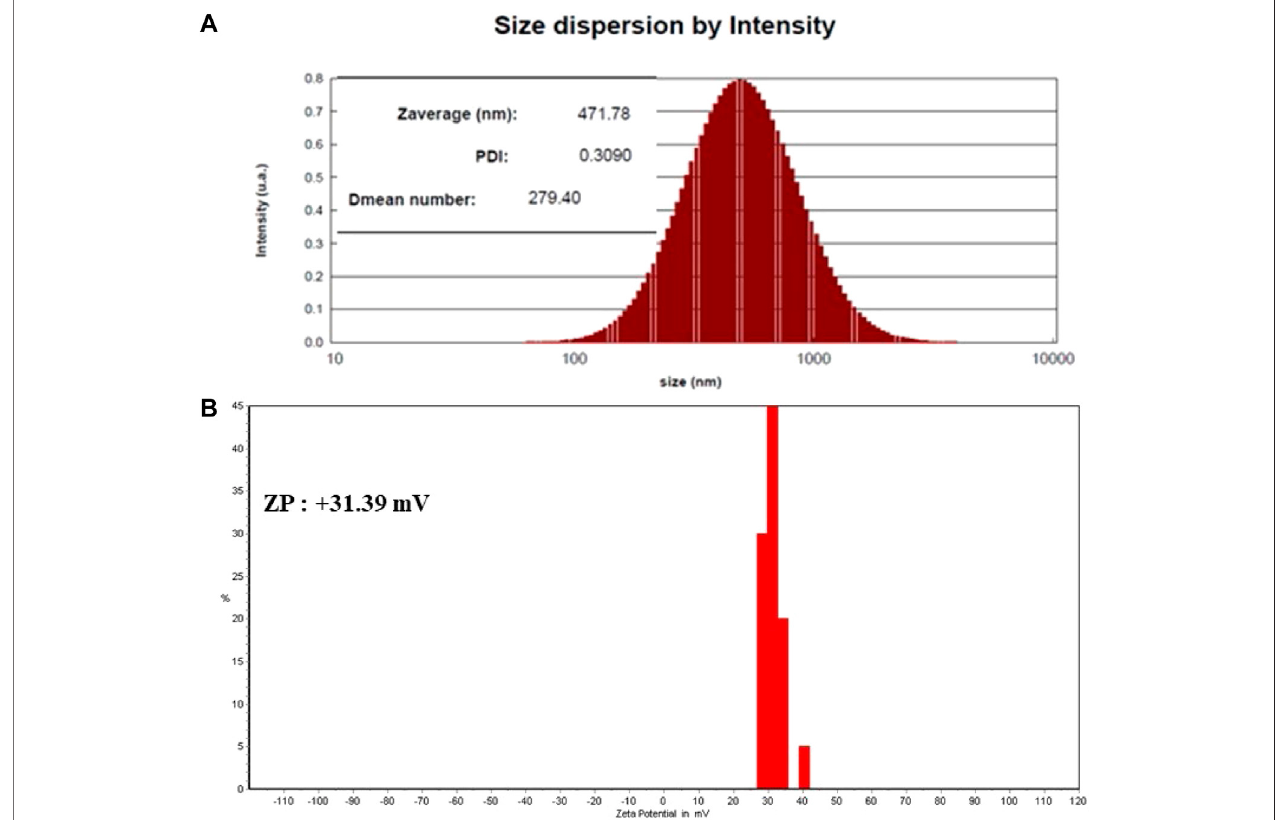
FIGURE 1 | (A) DLS analysis (Ps: 279.40 nm and PDI: 0.3) and (B) surface charge (+31.69 mV) of SEO-SCF-NPs.